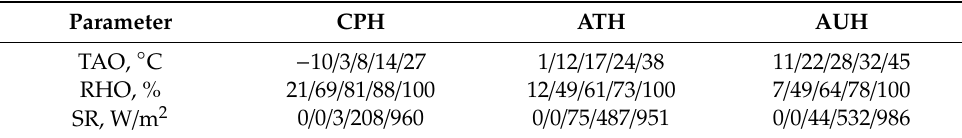
Table 4. Summary of the weather data parameters used in the building simulation model for Copenhagen (CPH), Athens (ATH) and Abu Dhabi (AUH). The format corresponds to: Minimum / First Quartile / Median / Third Quartile /